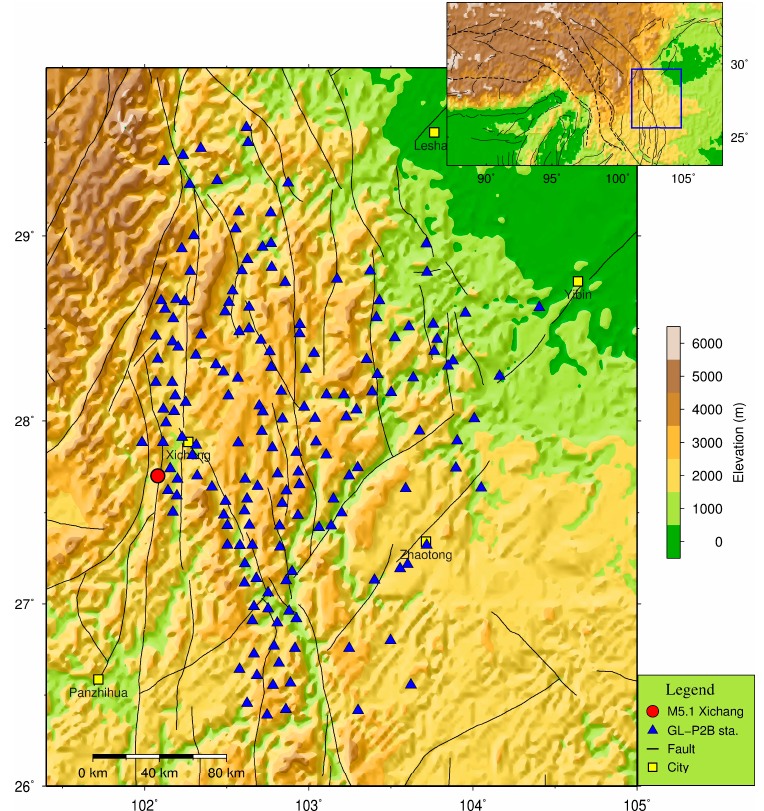
Figure 3. Station distribution of the GL-P2B based seismic sensor array shown as blue triangles. The red circle represents the epicenter of the 31 October 2018, M 5.1 Xichang earthquake. A large map with the marked study region is shown in the inset. Black lines indicate faults reported by Deng’s research [39].